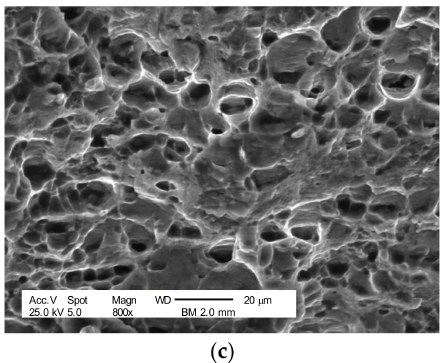
Figure 5. Scanning electron microscope fractography of the BM+CRed samples deformed along the cold rolling direction: ( a ) ∆ h = 0 mm; ( b ) ∆ h = 0.1 mm; ( c ) ∆ h = 0.5 mm.